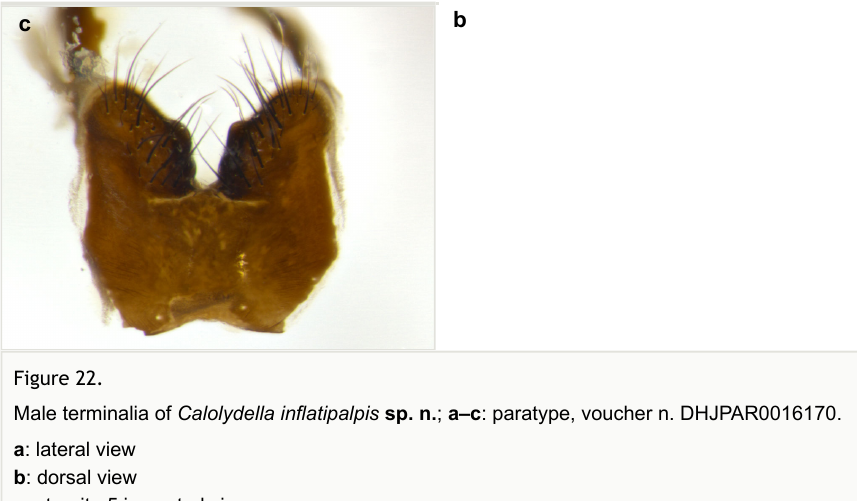
Female (Fig. 21d, e, f). Length: 5–7mm. Fronto-orbital plate 1.6X as wide as in male; palpus significantly inflated apically.